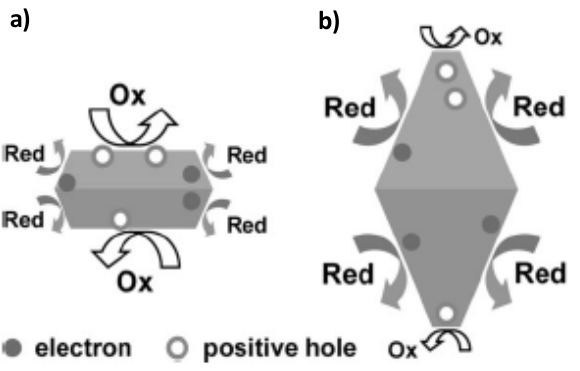
Figure 14. Schematic images of spatial separation of redox sites on anatase TiO with specific exposed crystal faces: decahedral particle with ( a ) a larger surface area of oxidation sites and smaller surface area of reduction sites and ( b ) a smaller surface area of oxidation sites and larger surface area of reduction sites. Reprinted with permission from ref. [107]. Copyright 2009 American Chemical Society.